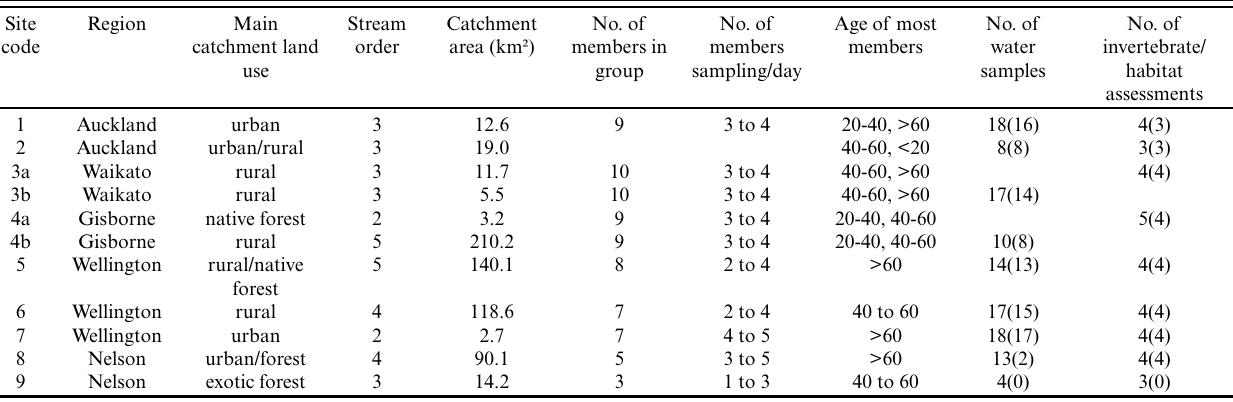
Table 1 . Characteristics of sites, group composition, and data. Sites 3a and 3b were monitored by the same group, as were sites 4a and 4b (site a for invertebrates, site b for water quality). Values in final two columns refer to no. of samples collected and (in parentheses) number used in